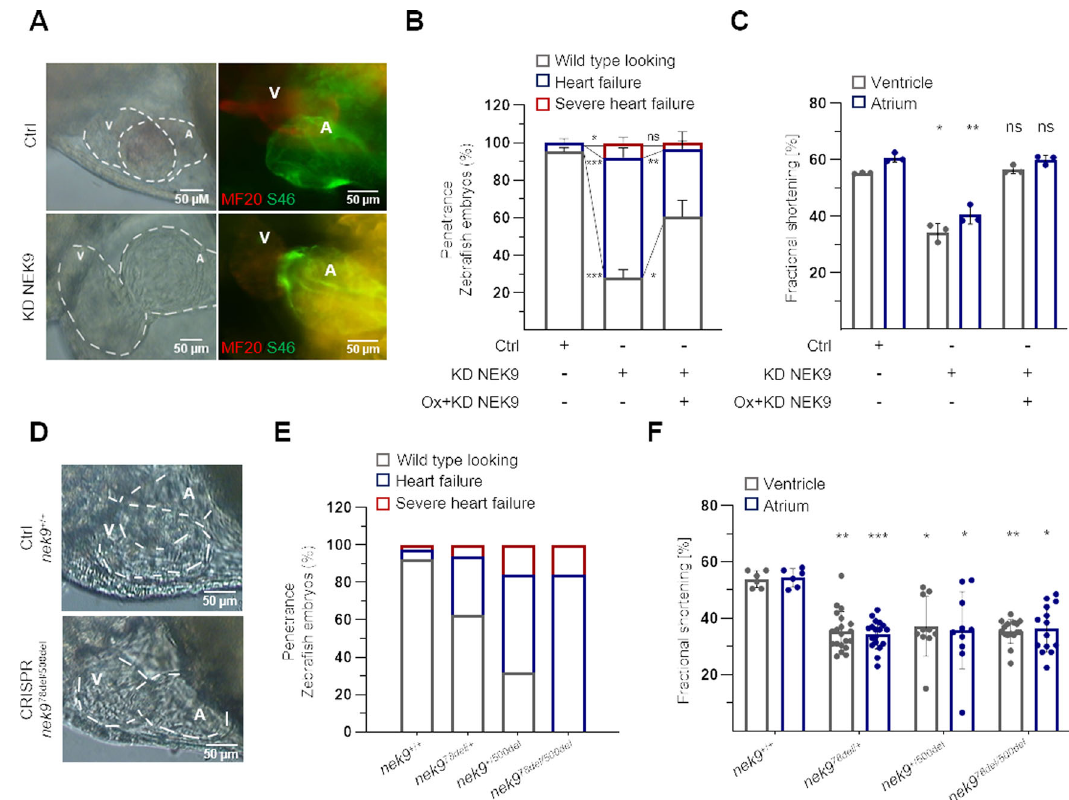
Fig. 4 | Functional analysis of NEK9 in-vivo. A Lateral view of zebra fi sh embryo hearts 72h post fertilization (hpf) injected with control oligonucleotides or anti- senseoligonucleotidesblockingthetranslationalstartsiteof nek9 (KDNEK9)(left). Immunostaining of atrium-speci fi c (A) and ventricle-speci fi c (V) myosin heavy chains (green: antibody against atrial-speci fi c myosin (S46), red: antibody against ventricular and atrial myosin (MF20)) (right). B Phenotype rescue of KD NEK9. Zebra fi sheggswereinjectedwith nek9 mRNA(Ox+KDNEK9)followedbyKDNEK9 in one-cell stage. Analysis was performed at 72 hpf. Data are mean±SD (Ctrl, n =143;KDNEK9, n =192;Ox+KDNEK9, n =155 fi shembryosoutof3experiments). * P <0.05;** P <0.01;*** P <0.001bytheanalysisoftwo-tailedpairedStudent ’ st-test. C Fractional shortening (FS) of zebra fi sh morphants at 72 hpf. Data are mean±SD (Ctrl, n =25; KD NEK9, n =21; Ox + KD NEK9, n =21 fi sh embryos out of 3 experi- ments). * P <0.05; ** P <0.01 by the analysis of two-way ANOVA followed by Bon- ferroni ’ s multiple comparisons test. The respective heart rate is shown in